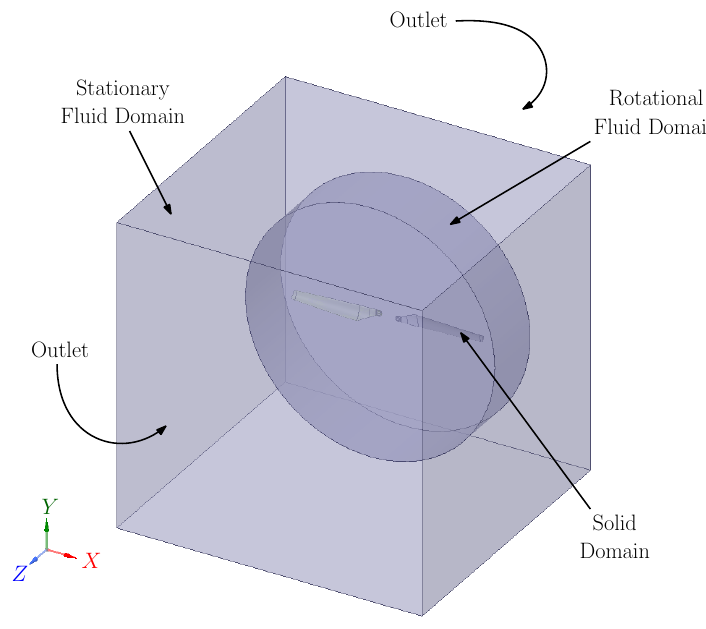
Figure 17. Boundary conditions and computational